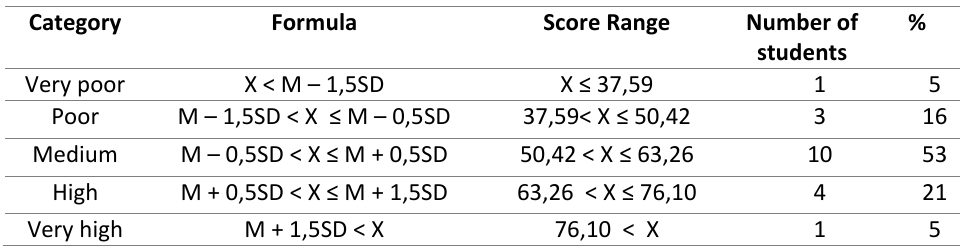
Table 7. Analysis of Baitussalam II Students’